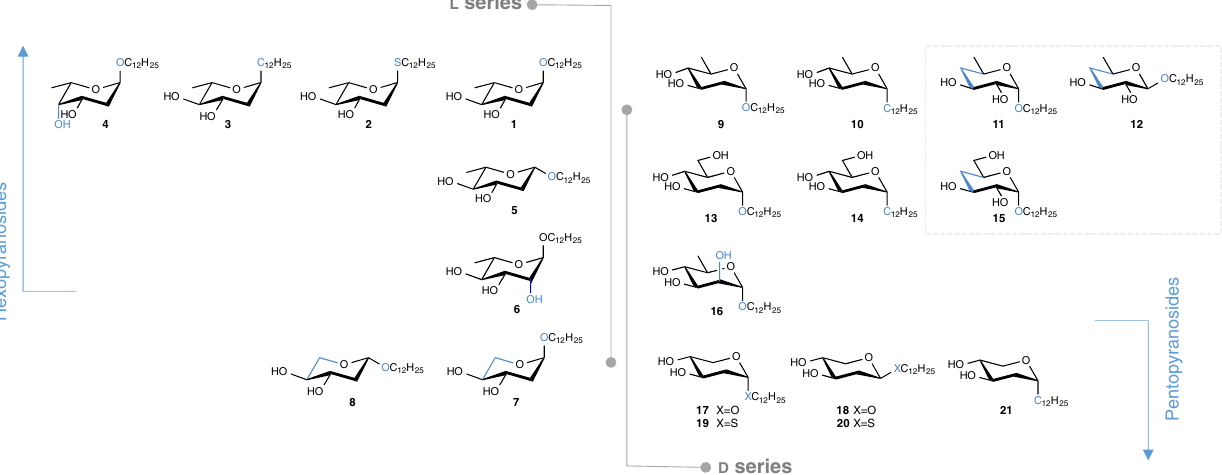
Fig. 1 Lead series generated by chemical synthesis. Glycones differ in the deoxygenation pattern (2-deoxy, 4-deoxy, 6-deoxy, 2,6-dideoxy and 4,6- dideoxy), D - and L -con fi guration, anomeric con fi guration, and atom linkage to the dodecyl chain (details on synthesis are given in Supplementary